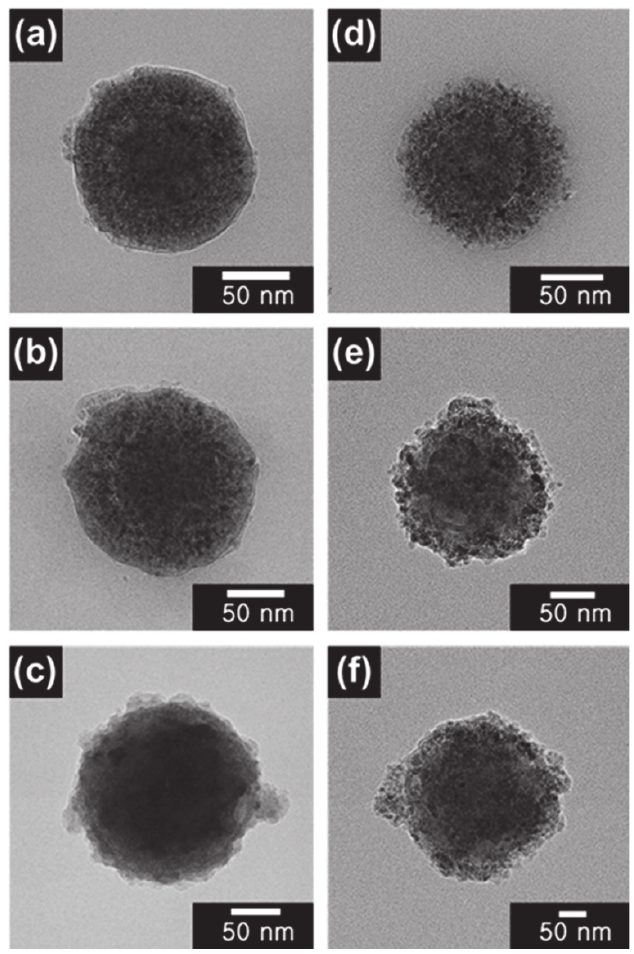
Figure 5. TEM images of ( a ) 130 nm ST CSNs, ( b ) 160 nm ST CSNs, ( c ) 190 nm ST CSNs, ( d ) 140 nm SBT CSNs, ( e ) 170 nm SBT CSNs, and ( f ) 200 nm SBT CSNs.